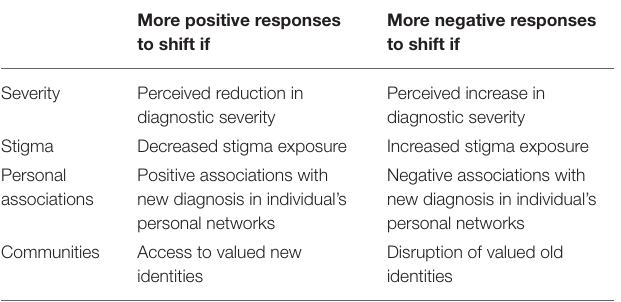
TABLE 2 | Diagnosis-specific factors : pathways through which they influenced responses to diagnostic shifts. More positive responses to shift